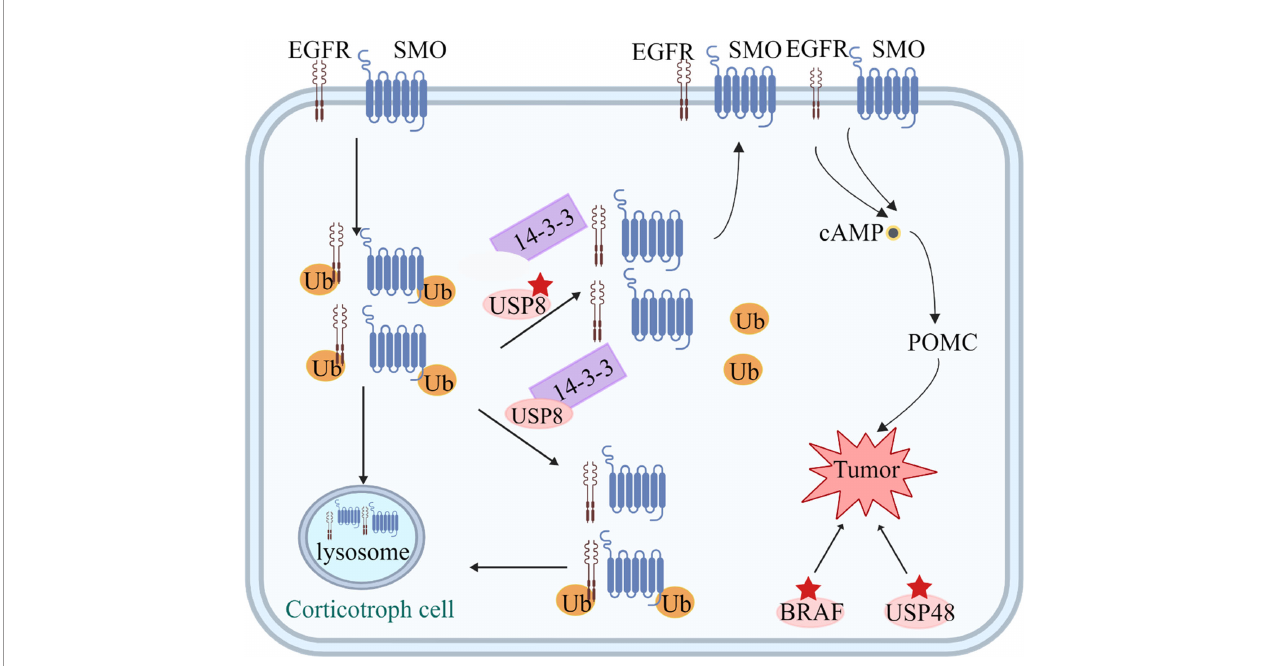
FIGURE 2 | Tumorigenic mechanisms in corticotroph cells. USP8 removes ubiquitin tags from targets, such as EGFR and Smoothened (SMO), preventing them from undergoing proteasomal degradation and allowing recycling back to the cell surface. Increased EGFR and SMO activity leads to increased cAMP and POMC levels. Mutated USP8 cannot bind 14-3-3 protein and undergoes cleavage, which increase enzymatic activity, leading to increased deubiquitination of EGFR and SMO and higher expression of the two proteins on the cell membrane. USP48 mutations and gain-of-function mutations of BRAF probably play a similar role to